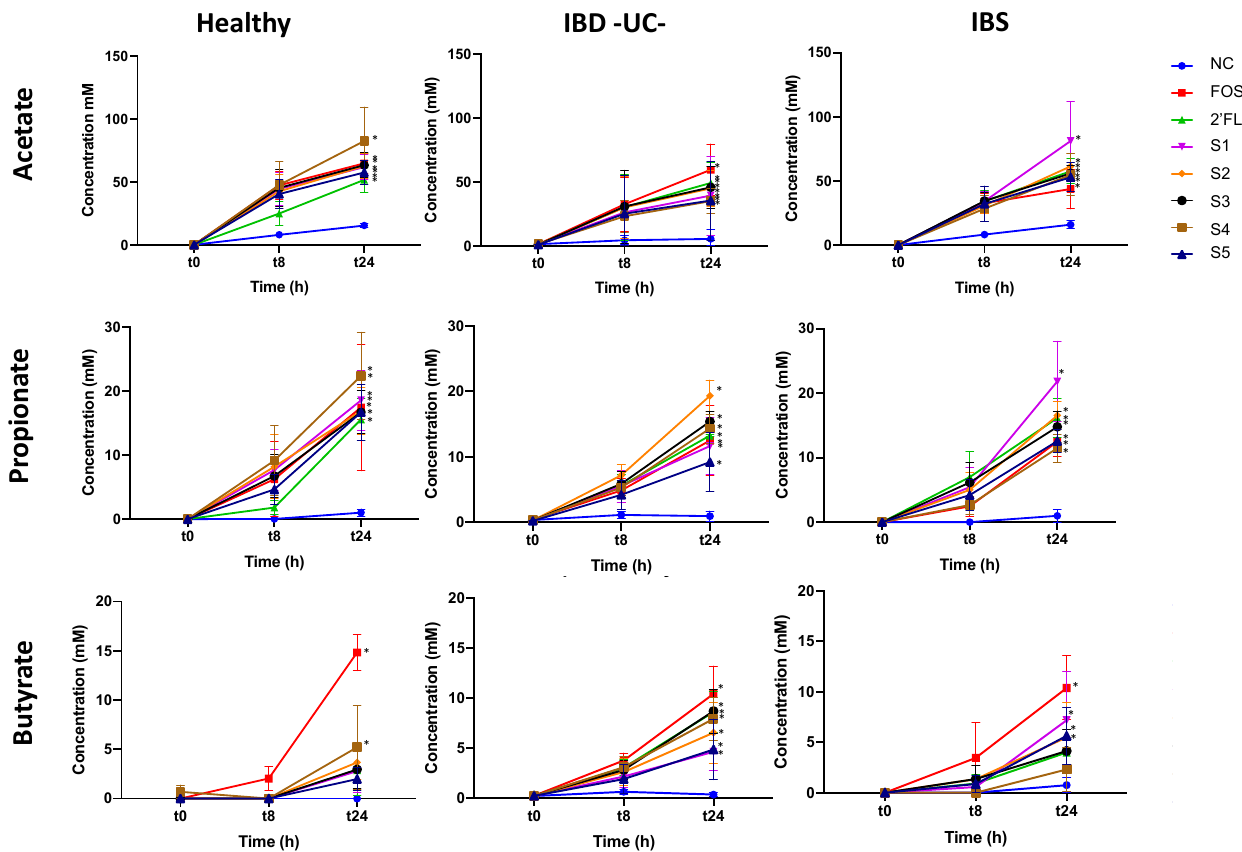
Figure 2. Acetate, propionate and butyrate concentration at 0, 8, and 24 h of fermentation with no substrate/negative control (NC); positive control (FOS / inulin mixture); 2 ′ -FL; S1: 2 ′ -FL + L. acidophilus NCFM + B. lactis Bi-07; S2: 2 ′ -FL + L. acidophilus NCFM + B. lactis Bi-07 + B. lactis Bl-04 + L. paracasei Lpc-37; S3: 2 ′ -FL + L. acidophilus NCFM + B. lactis Bi07 + L. rhamnosus GG; S4: 2 ′ -FL + L. rhamnosus GG; S5: 2 ′ -FL + L. salivarius UCC118. Error bars show SEM (n = 3). Significant differences from baseline (time 0) are denoted with * ( p ≤ 0.05) or ** ( p ≤ 0.01).